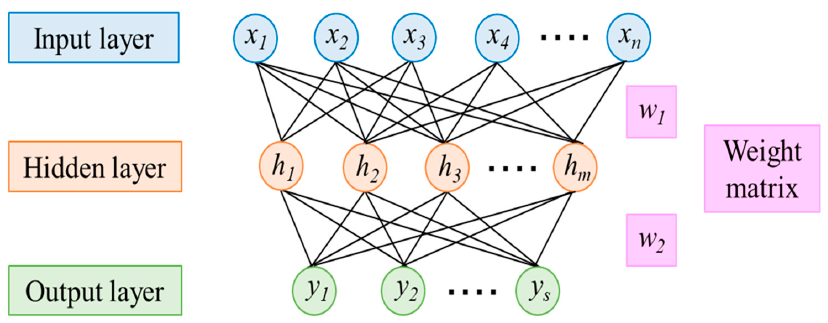
Figure 10. Simple auto encoding system.